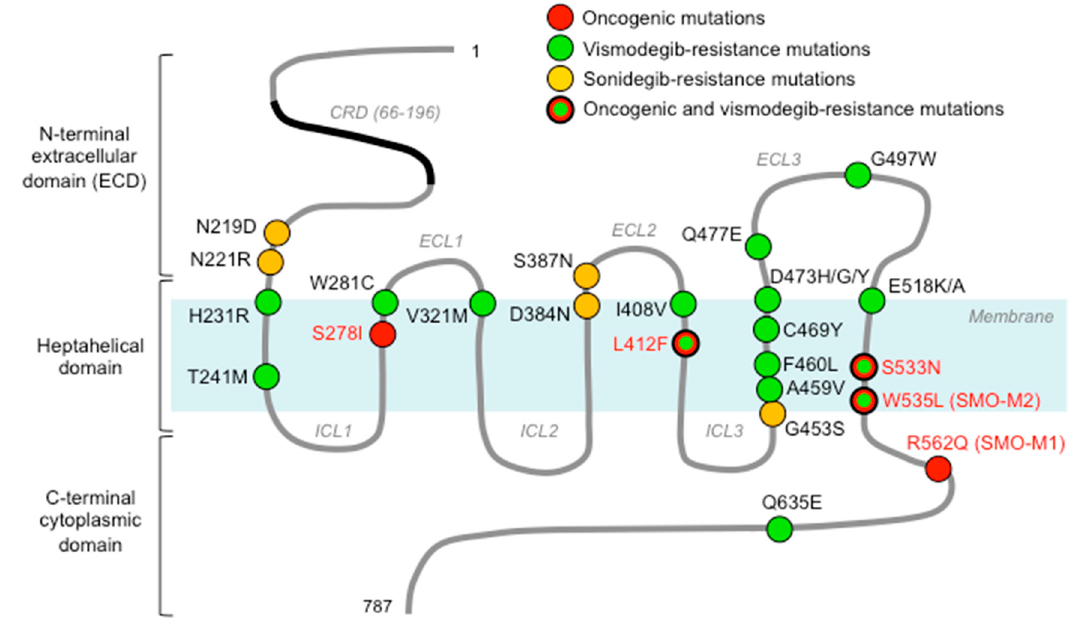
Figure 3. Schematic structure of the human SMO protein, showing the location of oncogenic mutations (red), vismodegib-resistance mutations (green), sonidegib-resistance mutations (orange) and oncogenic mutations associated with vismodegib resistance (red, green and black). Numbers represent amino acids. Human SMO contains 787 amino acids organized in three main domains: the N-terminal extracellular domain (ECD) (residues 1–220), containing a cysteine-rich domain (CRD); the heptahelical membrane spanning (7-TM) domain (TMD) (residues 221–558); the C-terminal cytoplasmic domain (residues 559–787). The TMD consists of seven transmembrane domains connected by three extracellular loops (ECL1–3) outside of the plasma membrane and three intracellular loops (ICL1–3). See Table 1 for details about mutations.